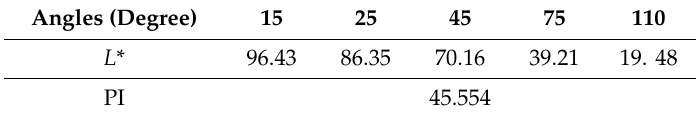
Table 12. Pearlescent characterization results of the M X2C2 sample for 12 h sonication time. Angles